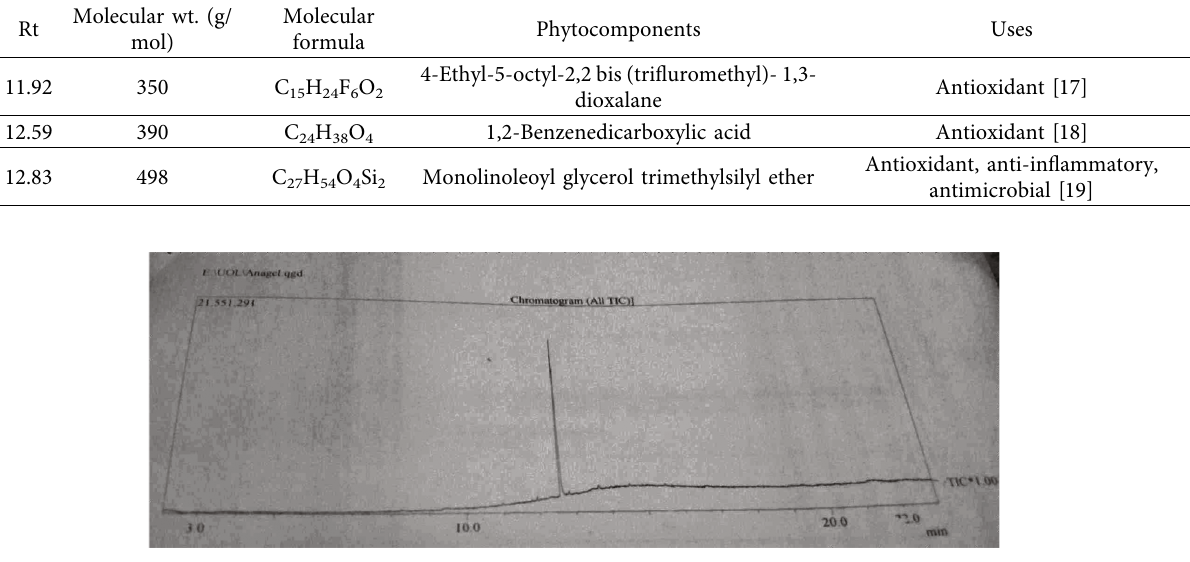
Figure 5: GC-MS chromatogram of the methanol extract of Anagallis arvensis